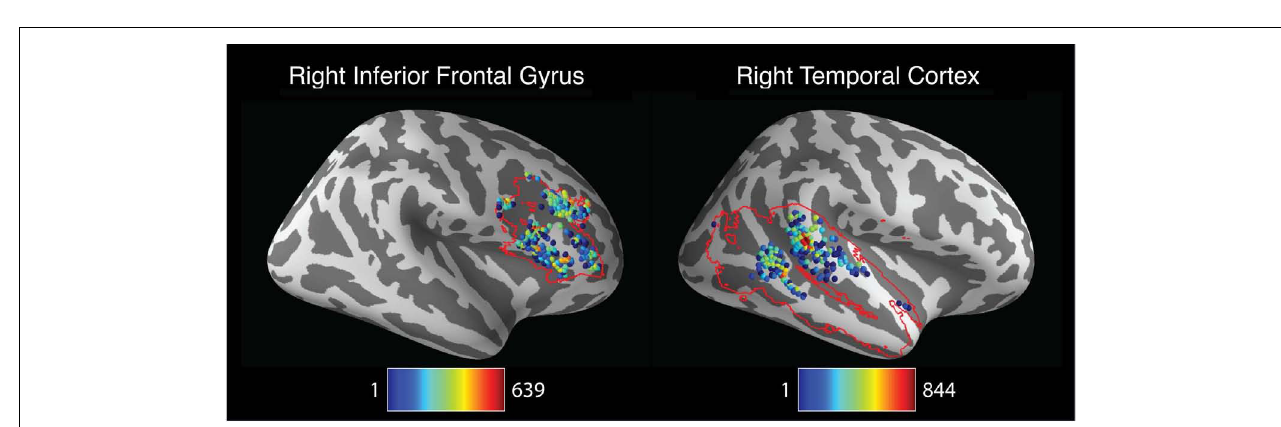
of pipelines yielding maximal activation for that location. For the right inferior frontal gyrus ROI (left panel), colors range from blue, indicating a single pipeline, to red, indicating 639 pipelines. For the right temporal cortex ROI (right panel), colors range from blue, indicating a single pipeline, to red, indicating 844